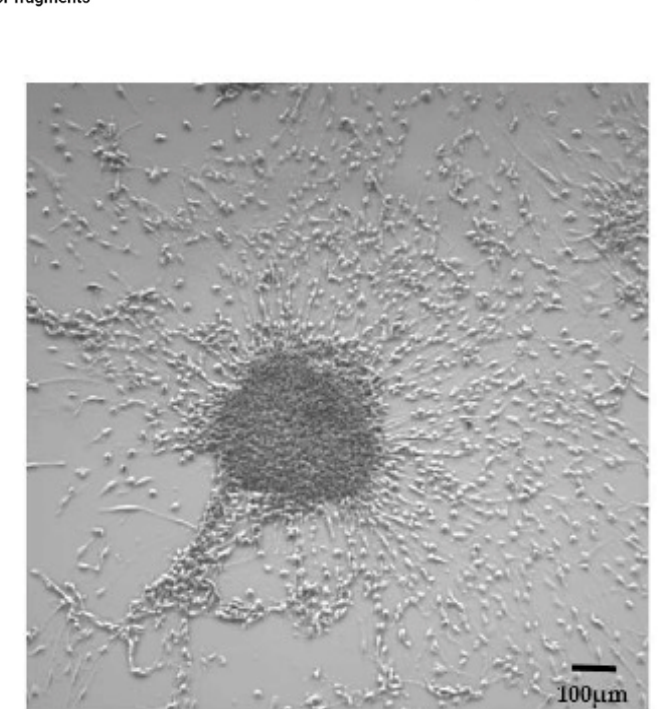
Figure 4. Explant culture and sun shape formation. ( a ) Main steps of the protocol for human glioblastoma explant generation. ( b ) Explant with a sun shape after one week of culture. Scale bar: 100 μ m.